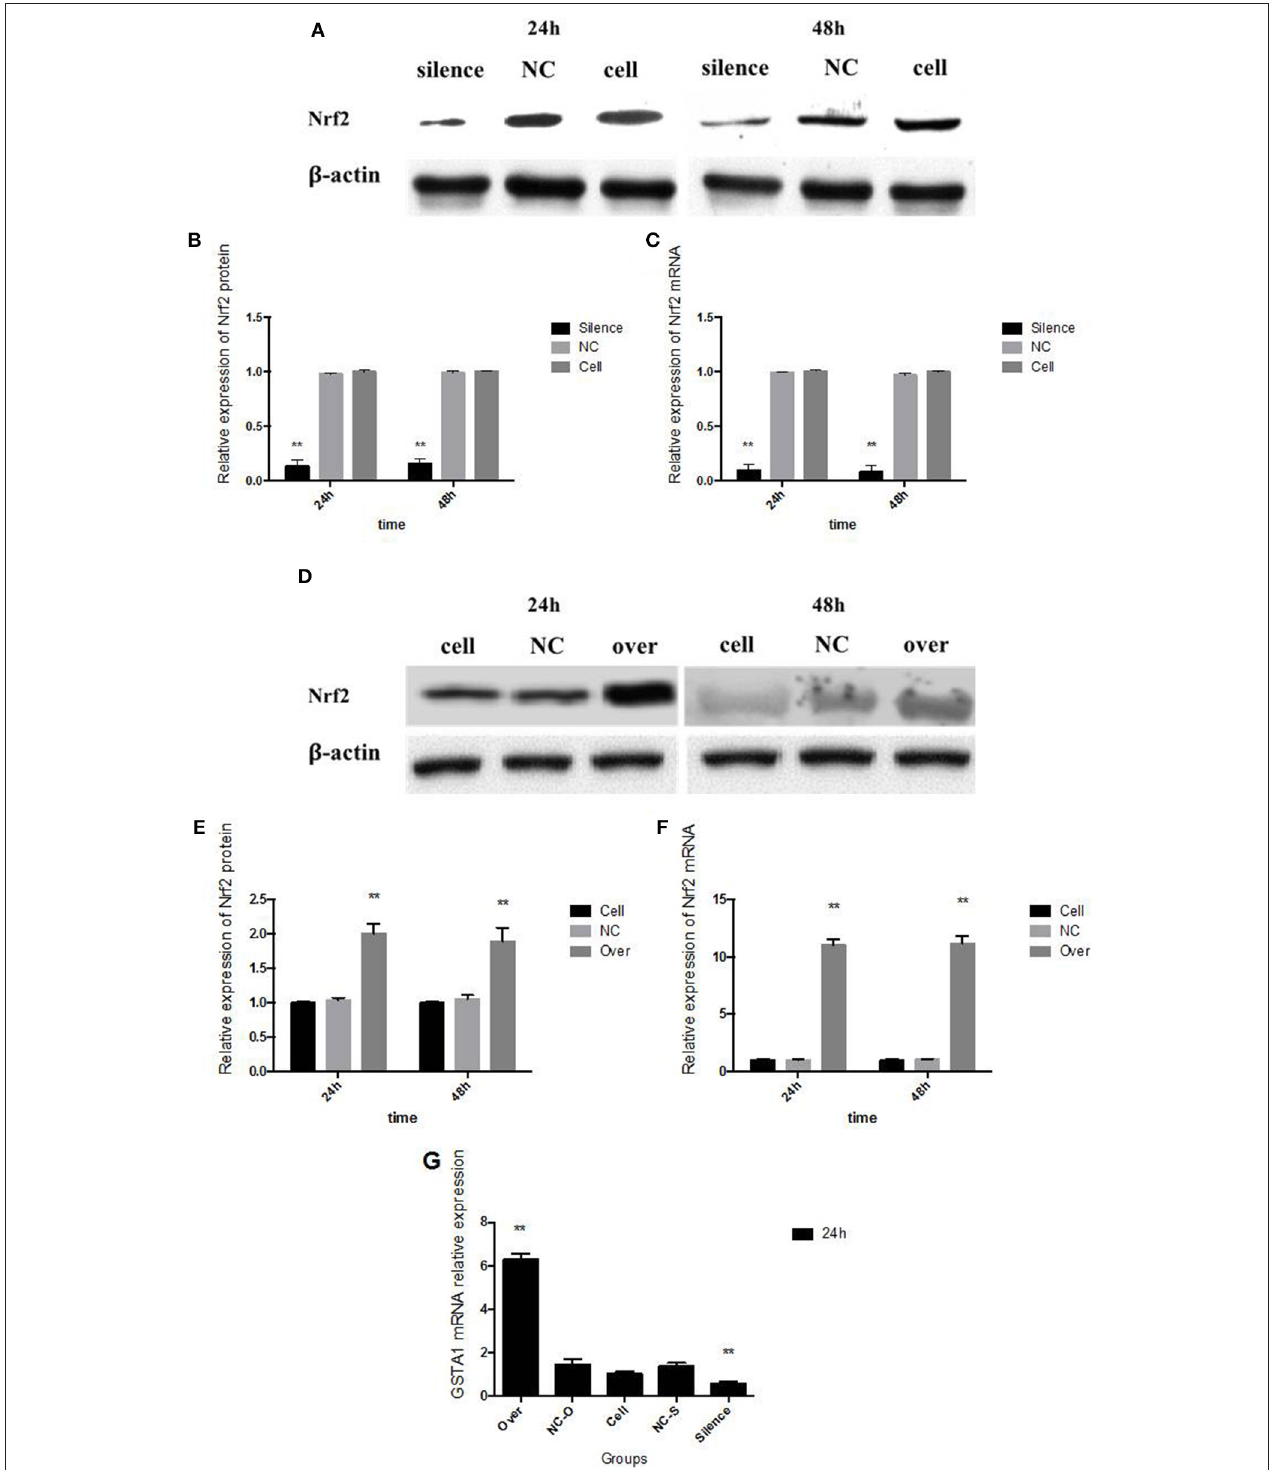
FIGURE 4 | Nrf2 gene silence and over expression. In Nrf2 siRNA transfected HepG2 cells, Nrf2 protein expression is shown in panel (A) and its quantity relative to β -actin is shown in panel (B) ; Nrf2 mRNA expression is shown in panel (C) . In pcDNA3-EGFP-C4-Nrf2 transfected HepG2 cells, Nrf2 protein expression is shown in panel (D) and its quantity relative to β -actin is shown in panel (E) ; Nrf2 mRNA expression is shown in panel (F) . The GSTA1 mRNA relative expression in different